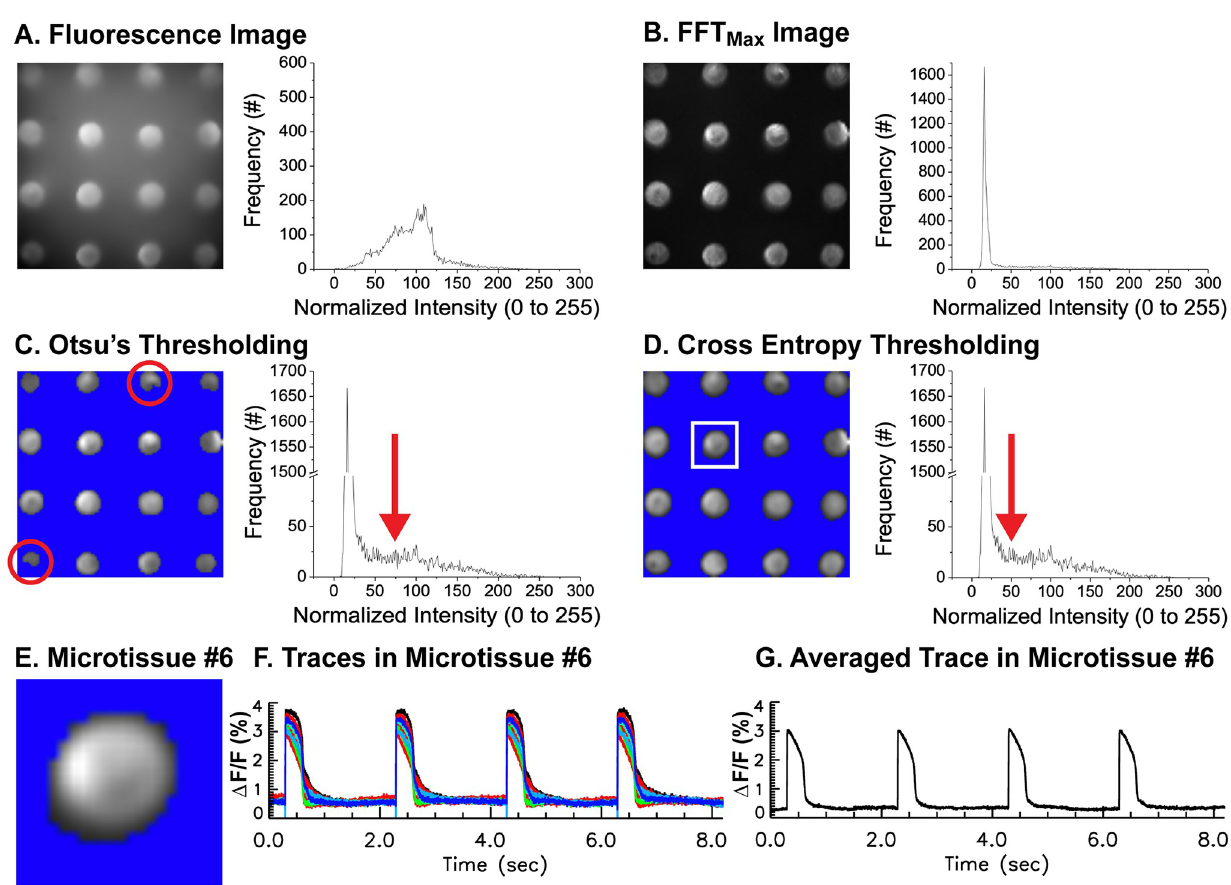
Fig 4. Segmentation of individual microtissues from fluorescence voltage images. (A) Sample fluorescence image (left) and a histogram of the sample image (right). Traces from each pixel were transformed to frequency domain using FFT, and the maximum FFT amplitude within pacing cycle length were calculated to reconstruct a FFT max image. (B) FFT max image that highlights regions showing full AP amplitude. The histogram of FFT max image (right panel) shows the best contrast image compared to fluorescence intensity in panel A. (C) Otsu’s thresholding and corresponding histogram in log scale showed detailed distribution of pixels with lower intensity. Since Otsu’s method selects a more conservative threshold value (red arrow), the segmentation often results in a smaller or distorted selection of microtissues (red circles). (D) Cross entropy thresholding via a minimum cross entropy algorithm improves the selection of pixels with AP signals (see the red arrow, mean threshold using cross entropy = 30 ± 17 vs. Otsu’s method = 72 ± 16, n = 30 microtissues). After segmentation, a region-labeling algorithm identified individual microtissues in a solid circular shape compared to Otsu’s method in panel C (mean area of microtissue detected using cross entropy = 160 ± 31 pixels vs. Otsu’s method = 99 ± 11 pixels, n = 30 microtissues). (E) Sample selected microtissue marked with a white box in panel D. (F) Superimposed traces from all the pixels within microtissue #6 in panel E. (G) Averaged trace from all the pixels in panel